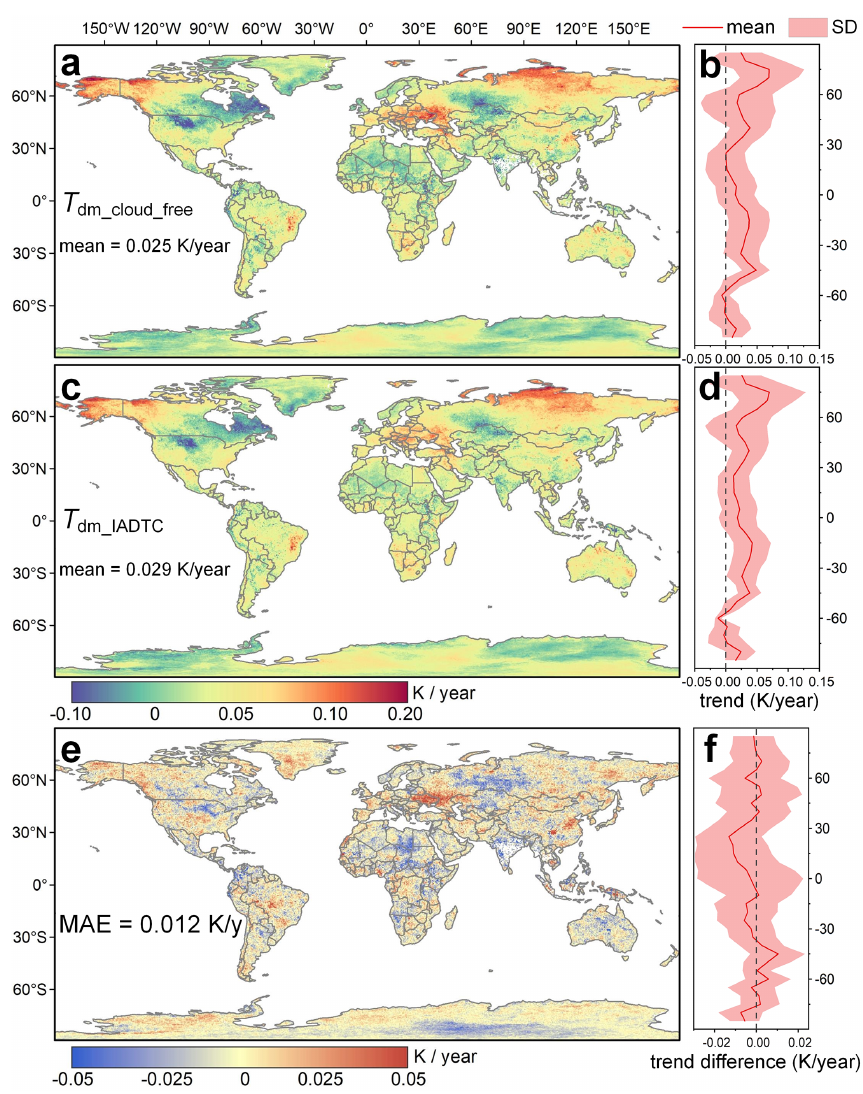
Figure 10. Global LST trends from 2003 to 2019. Panels (a) and (b) display the global LST trends based on T dm_cloud_free and their averaged results for 5 ◦ longitudinal intervals, respectively; panels (c) and (d) show the corresponding results for T dm_IADTC ; and panels (e) and (f) show the global LST trend differences between T dm_cloud_free and T dm_IADTC and their averages for 5 ◦ longitudinal intervals,